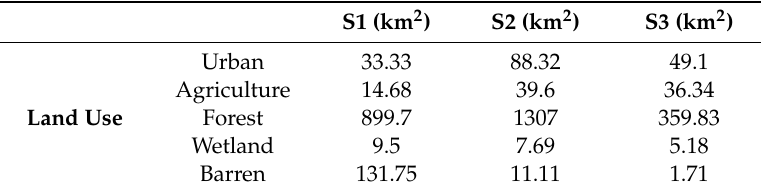
Table 2. General description of land use for study area indicated in Figure